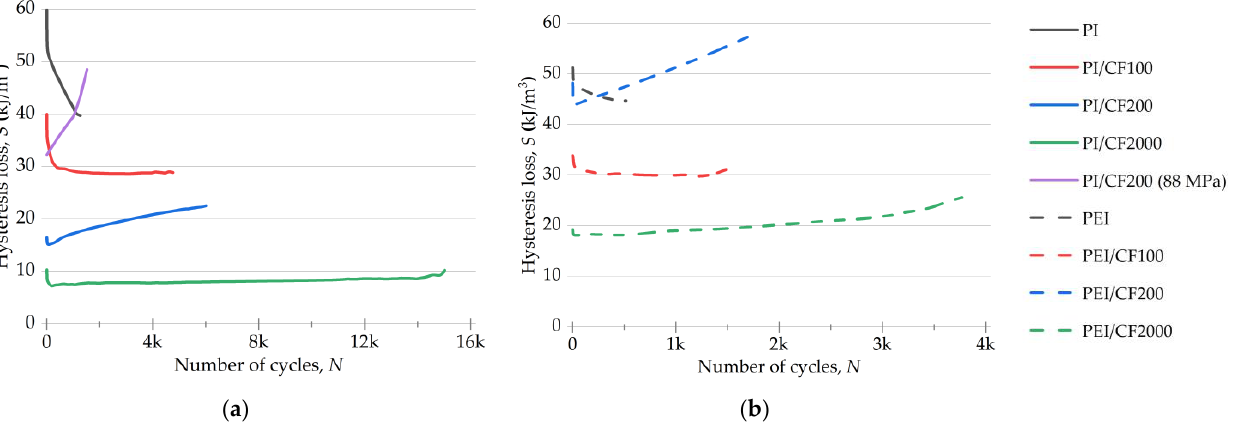
Figure 7. The changes in the loop areas S for the PI- ( a ) and PEI-based ( b ) composites under cyclic loads.